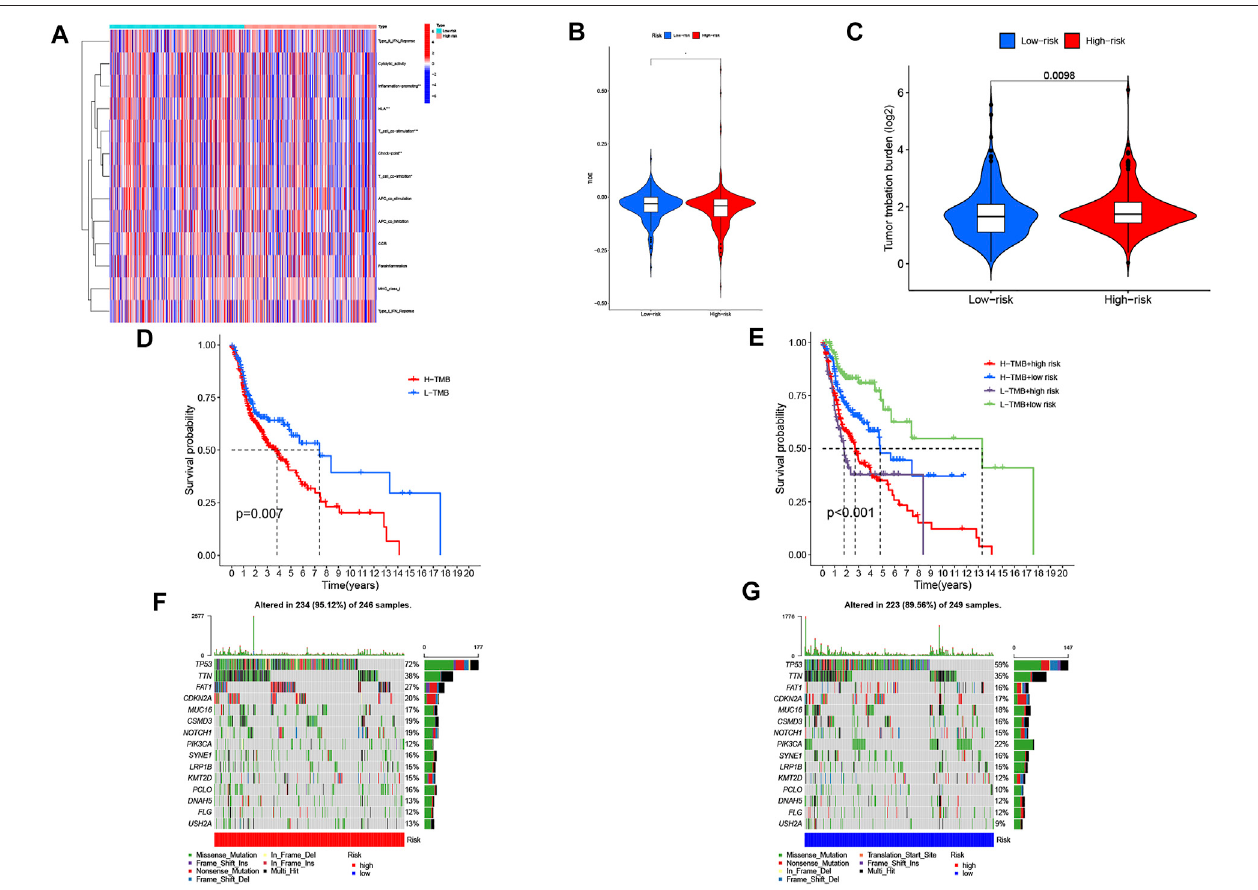
FIGURE7| Immunologicallandscapeinheadandnecksquamouscellcarcinoma(HNSC)patientsandrelationshipbetweentumormutationburden(TMB)andrisk score. (A) heatmapofthetumor-in fi ltratinglymphocytesbasedonsingle-samplegenesetenrichmentanalysisalgorithmsamongthehigh-andlow-riskgroupsinHNSC. * p < 0.05, ** p < 0.01, and *** p < 0.001. (B) comparison of TIDE prediction score between the high- and low-risk groups. (C) Analysis of TMB differences between the high- and low-riskgroups inHNSC. (D) survival analysiscurves ofthe high- and low-TMB groups. (E) TMB riskcombined with survivalcurveinHNSC. (F) waterfall plot of top 15 mutant genes in the high-risk group in HNSC. (G) waterfall plot of top 15 mutant genes in the low-risk group in HNSC.